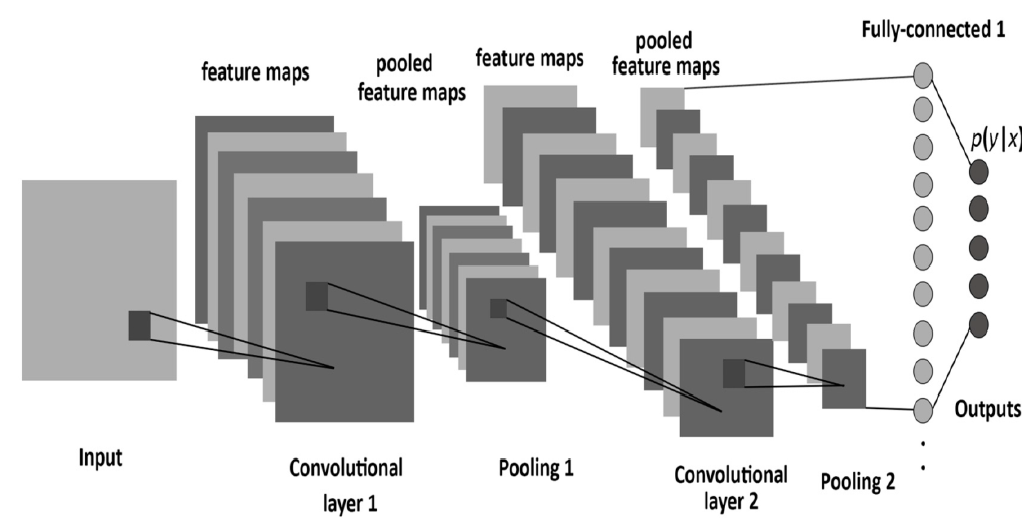
Figure 3. Structure of deep convolutional neural networks (CNN)